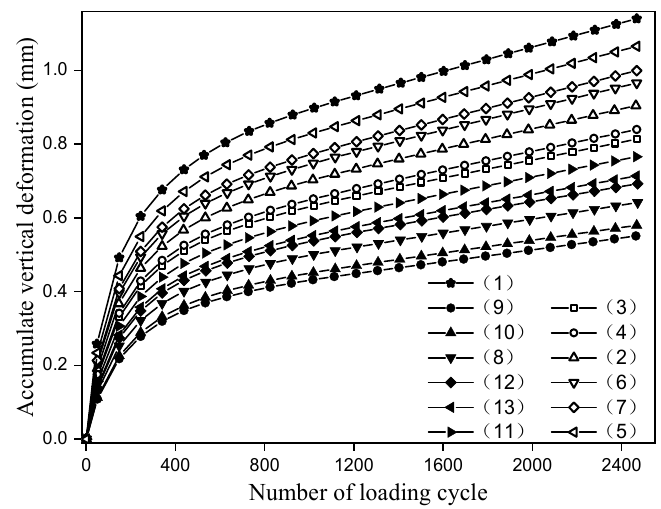
Figure 5. Rutting test results.